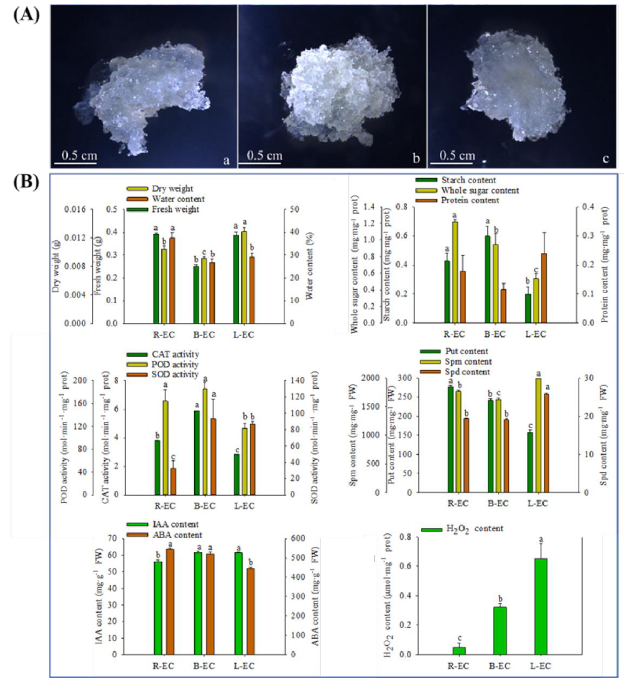
Figure 1. Morphological ( A ) and physiological ( B ) differences among Korean pine R-EC, B-EC, and L-EC. ( a ) R-EC. ( b ) B-EC. ( c ) L-EC. The scale bar represents 0.5 cm.